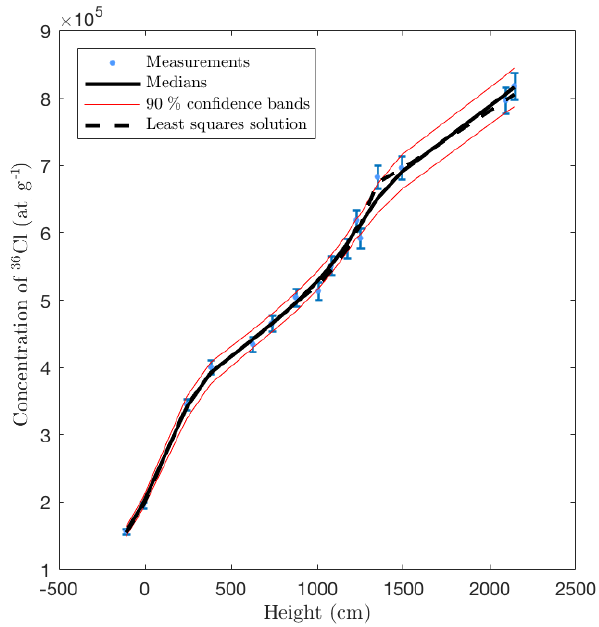
Figure 5. Gelman–Rubin diagnostic for the synthetic case with 146 36 Cl measurements Figure 6. Measured and sampled 36 Cl concentrations for the syn- thetic case with 16 36 Cl